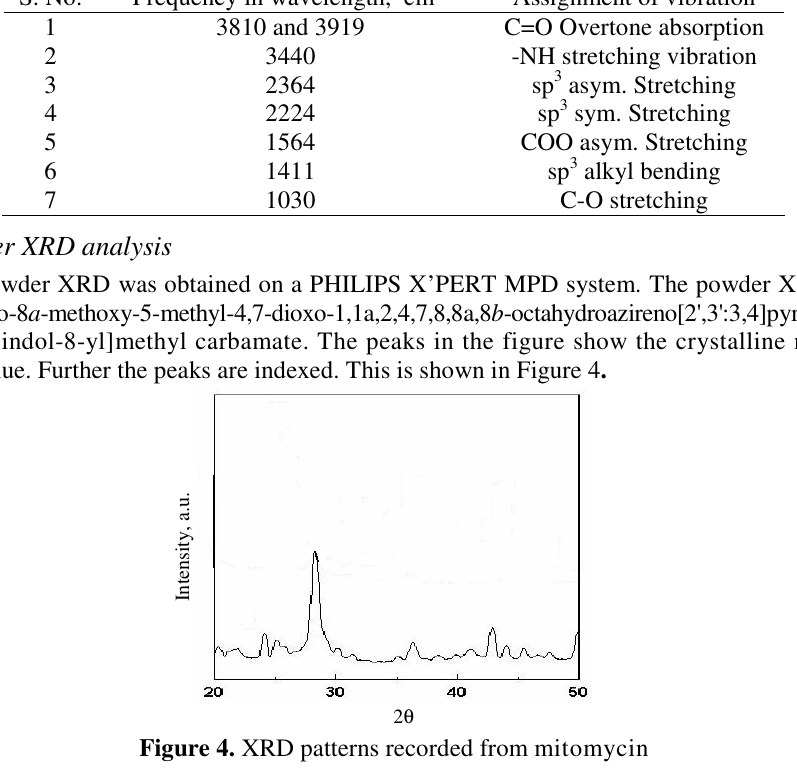
Table 1. Frequencies of the fundamental vibrations of GPC S. No.